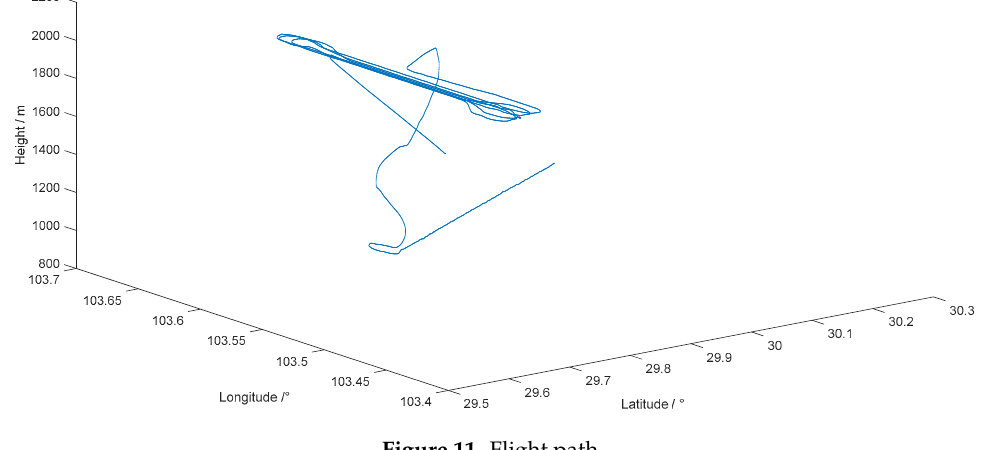
Figure 10. Cloud chart of plate element calculation stress in the case of lateral gust.